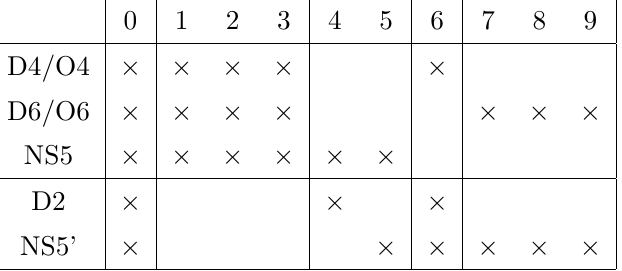
Table 1. The directions ( × ) in which branes extend for a configuration engineering ’t Hooft operators in the 4d U( N ) gauge theories. For the 4d N = 2 ∗ U( N ) gauge theory, the x 6 -direction is circle-compactified with a twist as in (2.1) and no D6-branes are introduced. We also list the directions of the orientifolds which we will discuss in sections 2.2 and 2.3 to realize gauge groups different from U( N )